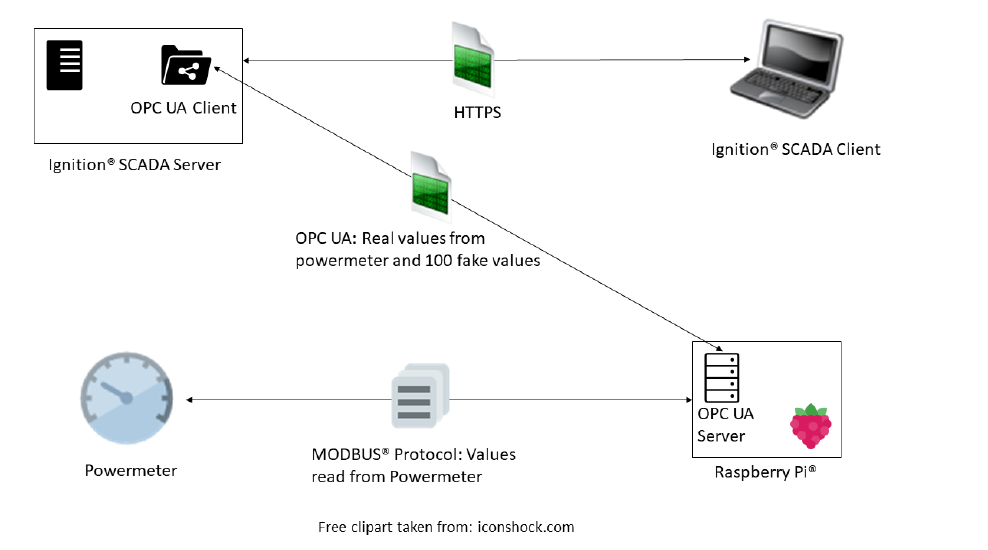
Figure 9. MTD Test